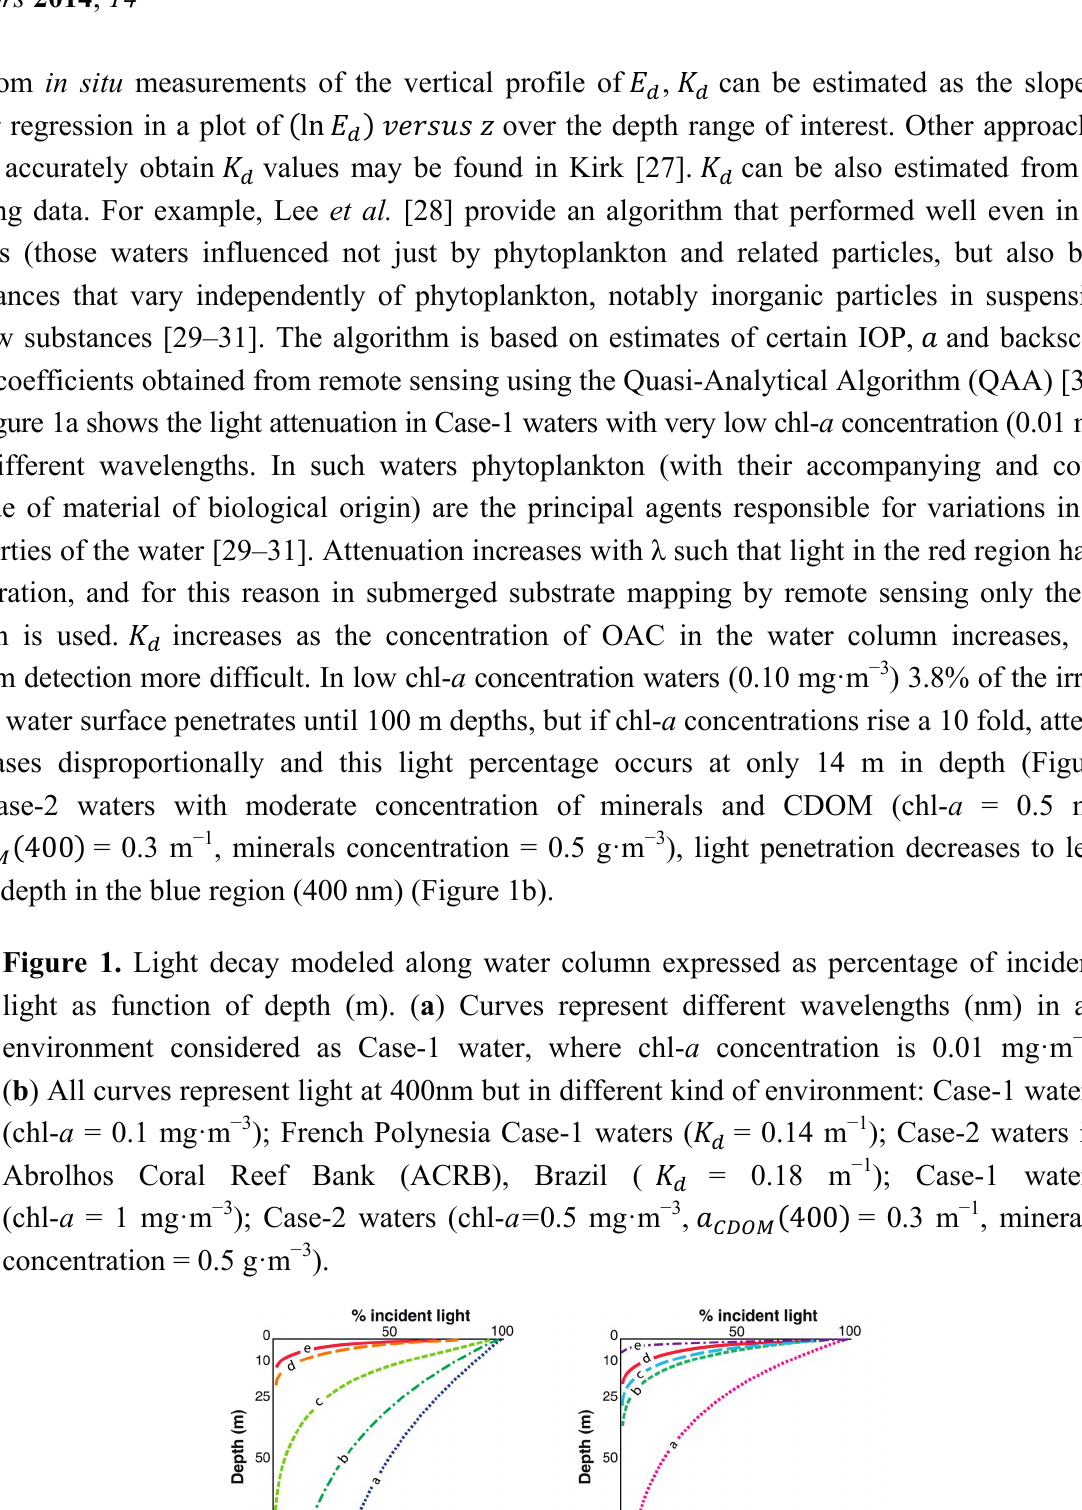
= 0.14 m − 1 ); Case-2 waters in (cid:3031) = 0.18 m − 1 ); Case-1 waters (cid:3031) (400) = 0.3 m − 1 , minerals (cid:3004)(cid:3005)(cid:3016)(cid:3014)